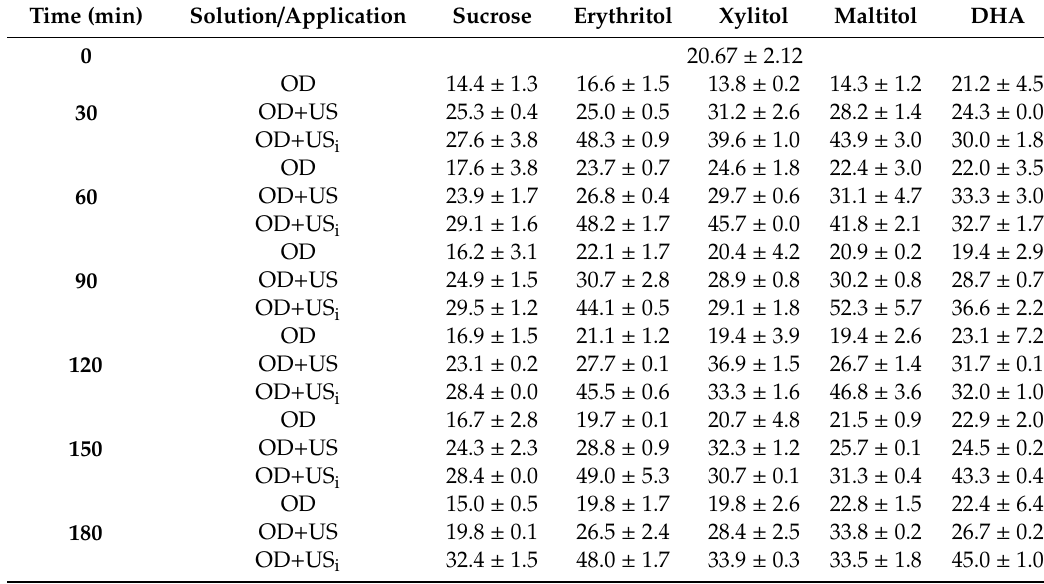
Table 12. Values of the browning index (BI) parameter during OD in di ff erent solutions. OD: osmotic dehydration; US: continuous sonication; USi: interval